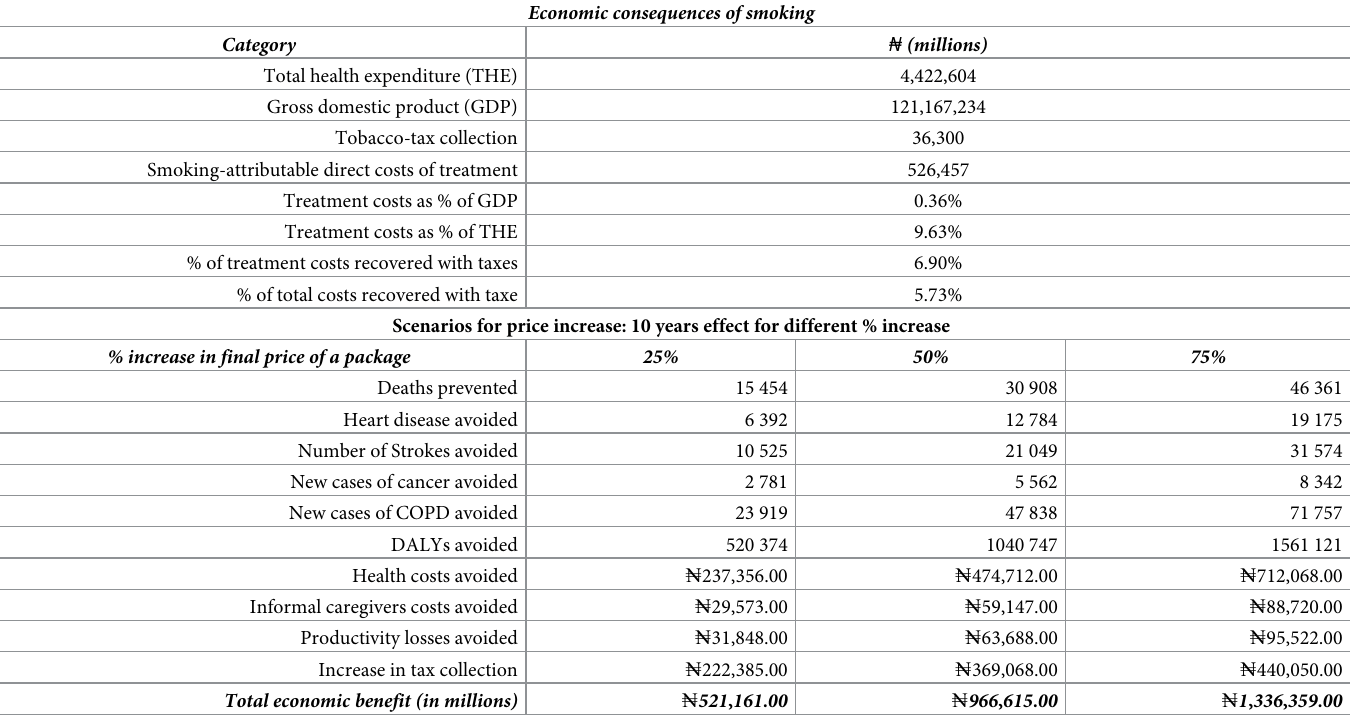
Table 5. Economic consequences of smoking and the potential effects of price increase–